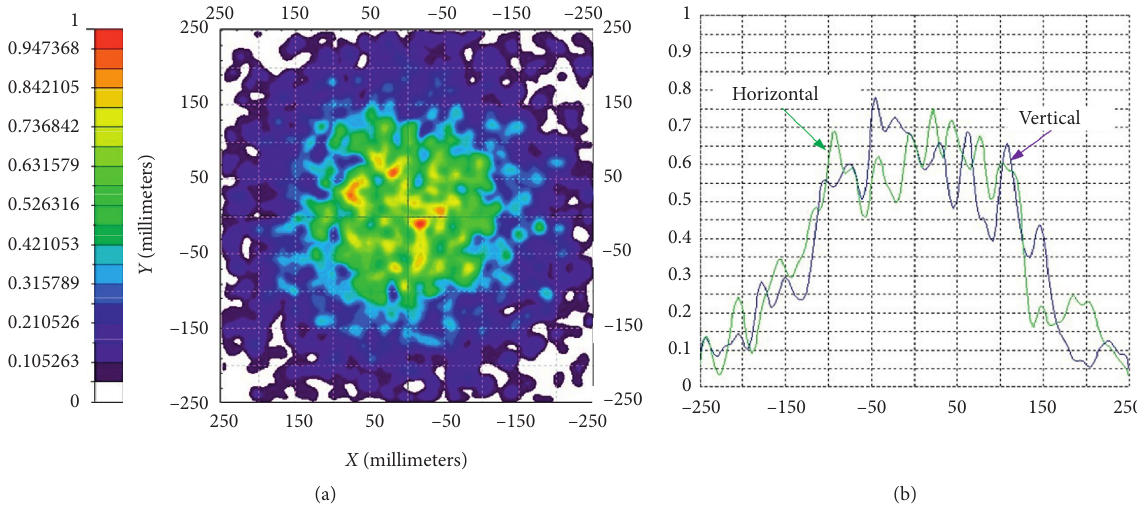
Figure 8: Total-irradiance map diagram of the receiving surface of the compound eye plano-convex lens with 127 monocular lenses and sunflower-shaped plano-convex lens